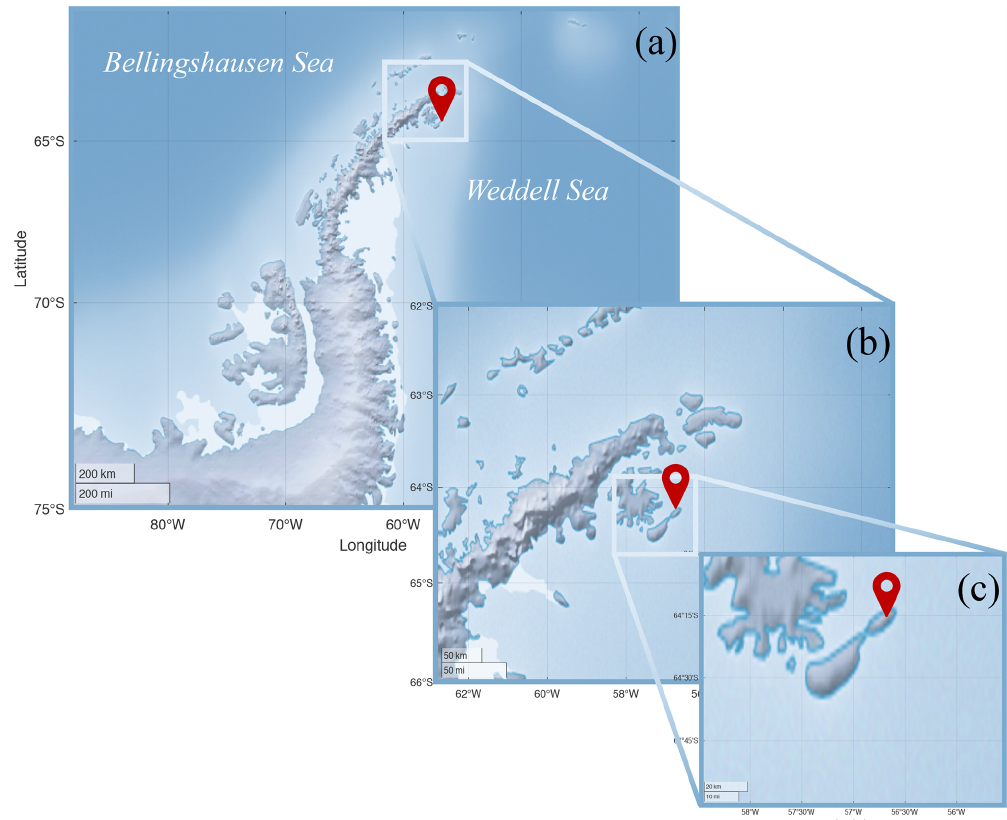
Figure 1. Map of the Antarctic Peninsula (a) , with zoomed-in view of the north sector (b) and of Seymour Island with Marambio Station (c) . The measurement location is indicated by the red pin in every